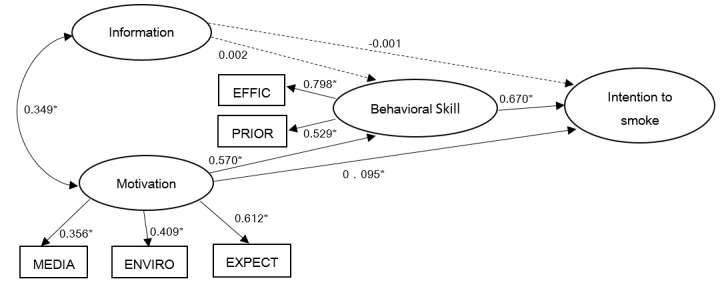
The preliminary IMB model predicting adolescent tobacco use among 16500 students.Oval represent multiple-indictor latent variables, rectangle represent single-indicator observable variables. Single-headed arrow means regression path. Double-headed arrow mean correlations. Regression coefficient are standardized (*means P<0.001). Dotted line indicates non-significant path from original IMB model.